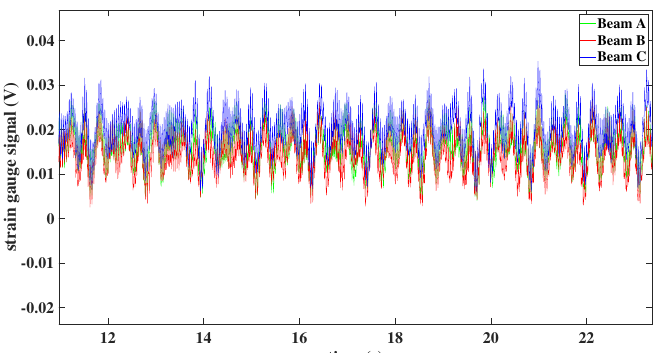
Figure 19. Time histories of individual beams with preset angle 90 ◦ and angular speed 50